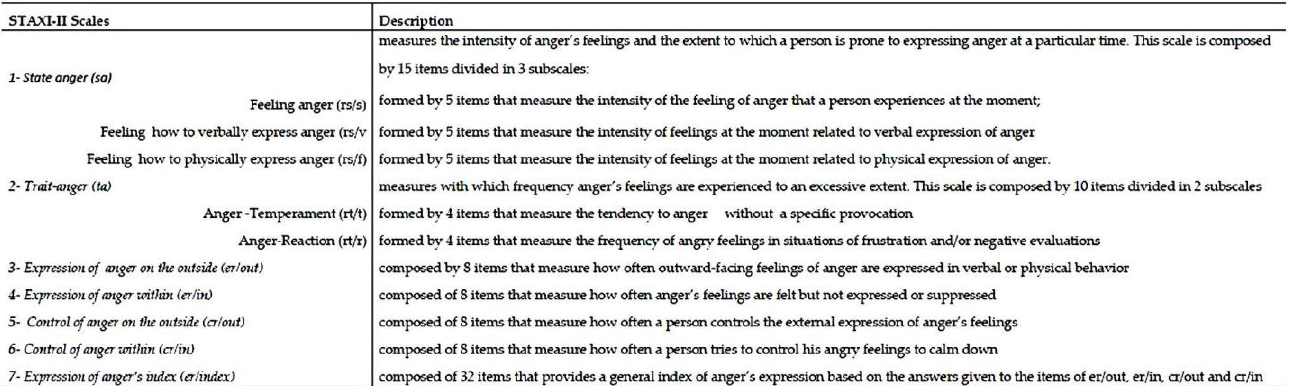
Figure 1. STAXI-II questionnaire. Description of each scale.